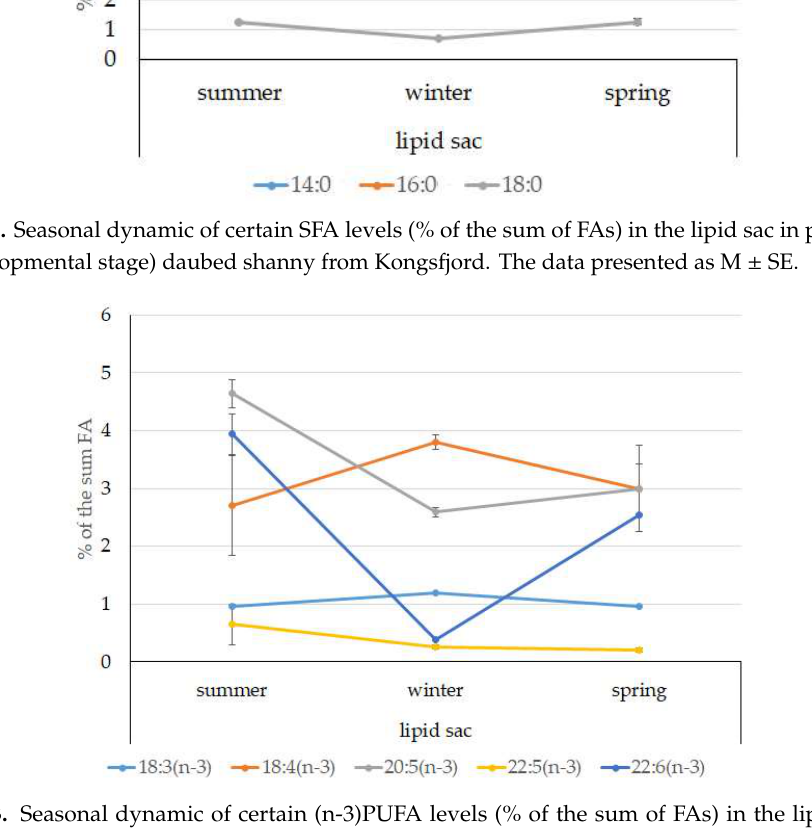
Figure 13. Seasonal dynamic of certain (n-3)PUFA levels (% of the sum of FAs) in the lipid sac in postlarval (L3 developmental stage) daubed shanny from Kongsfjord. The data presented as M ± SE.